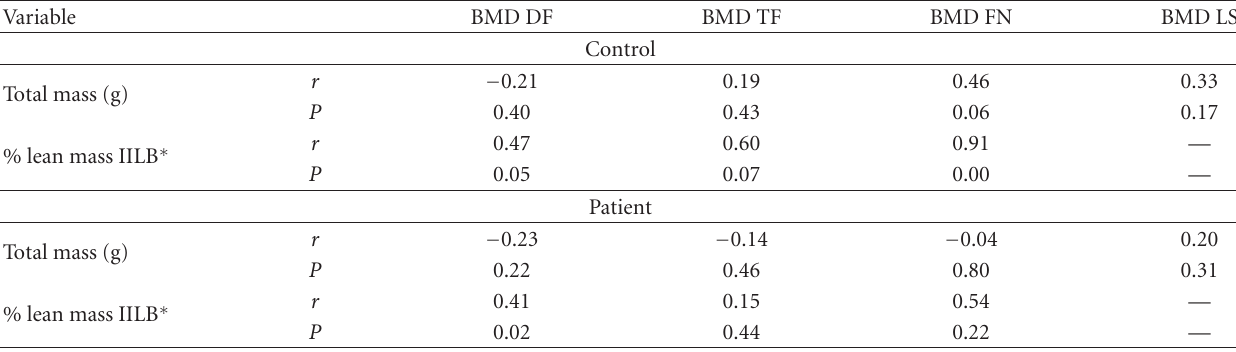
∗ lean mass IILB: % lean mass inferior